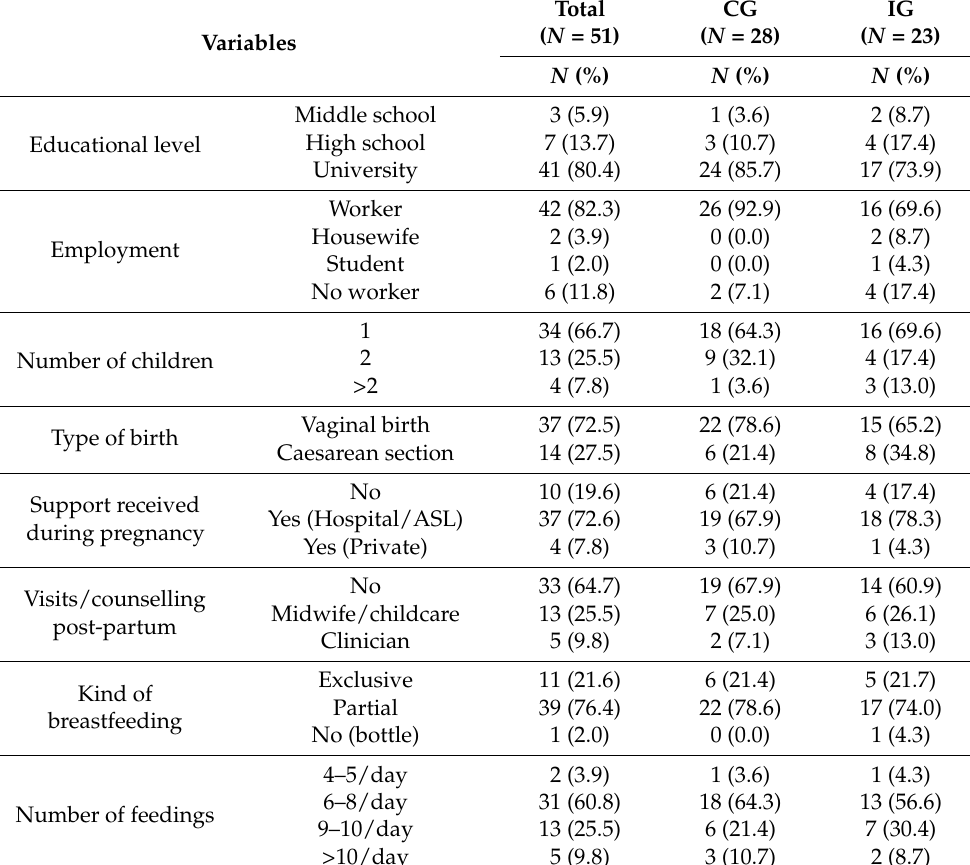
Table 1. Characteristics of the